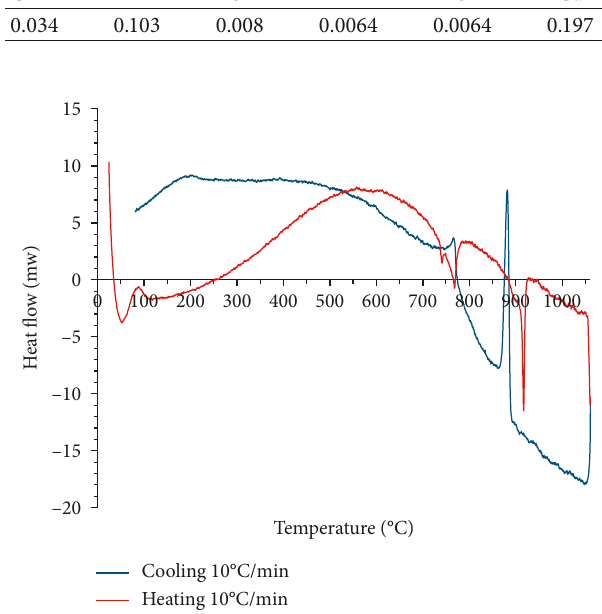
Figure 1: DSC curves of mild steel cooled and heated at 10 ° C/min.